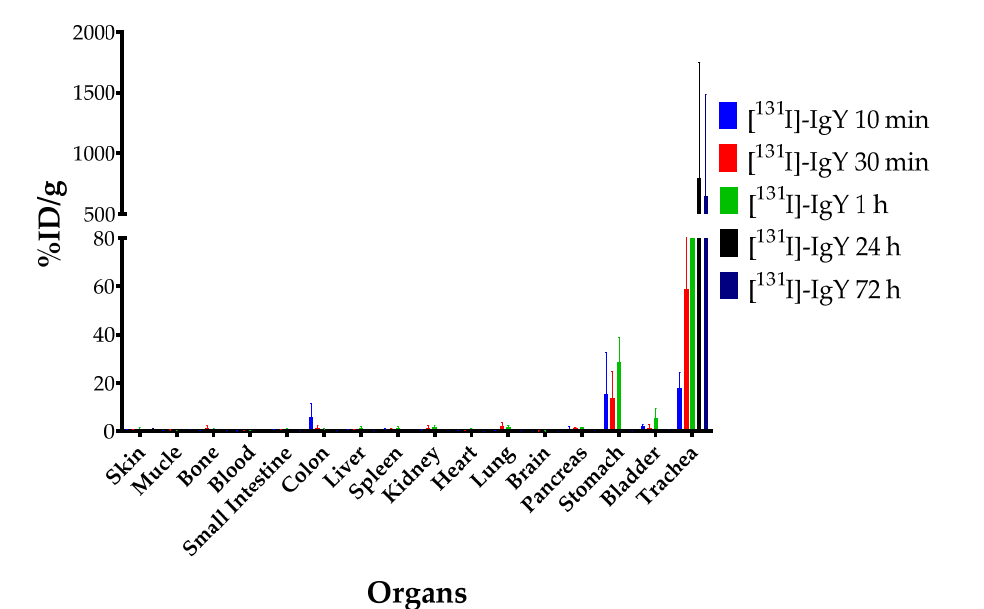
Figure 8. Organ accumulation of [ 131 I]-IgY anti-RBD spike SARS-CoV-2 in normal mice at five time points post intranasal administration, presented as percentage of injection dose per gram of organ (% ID/g).